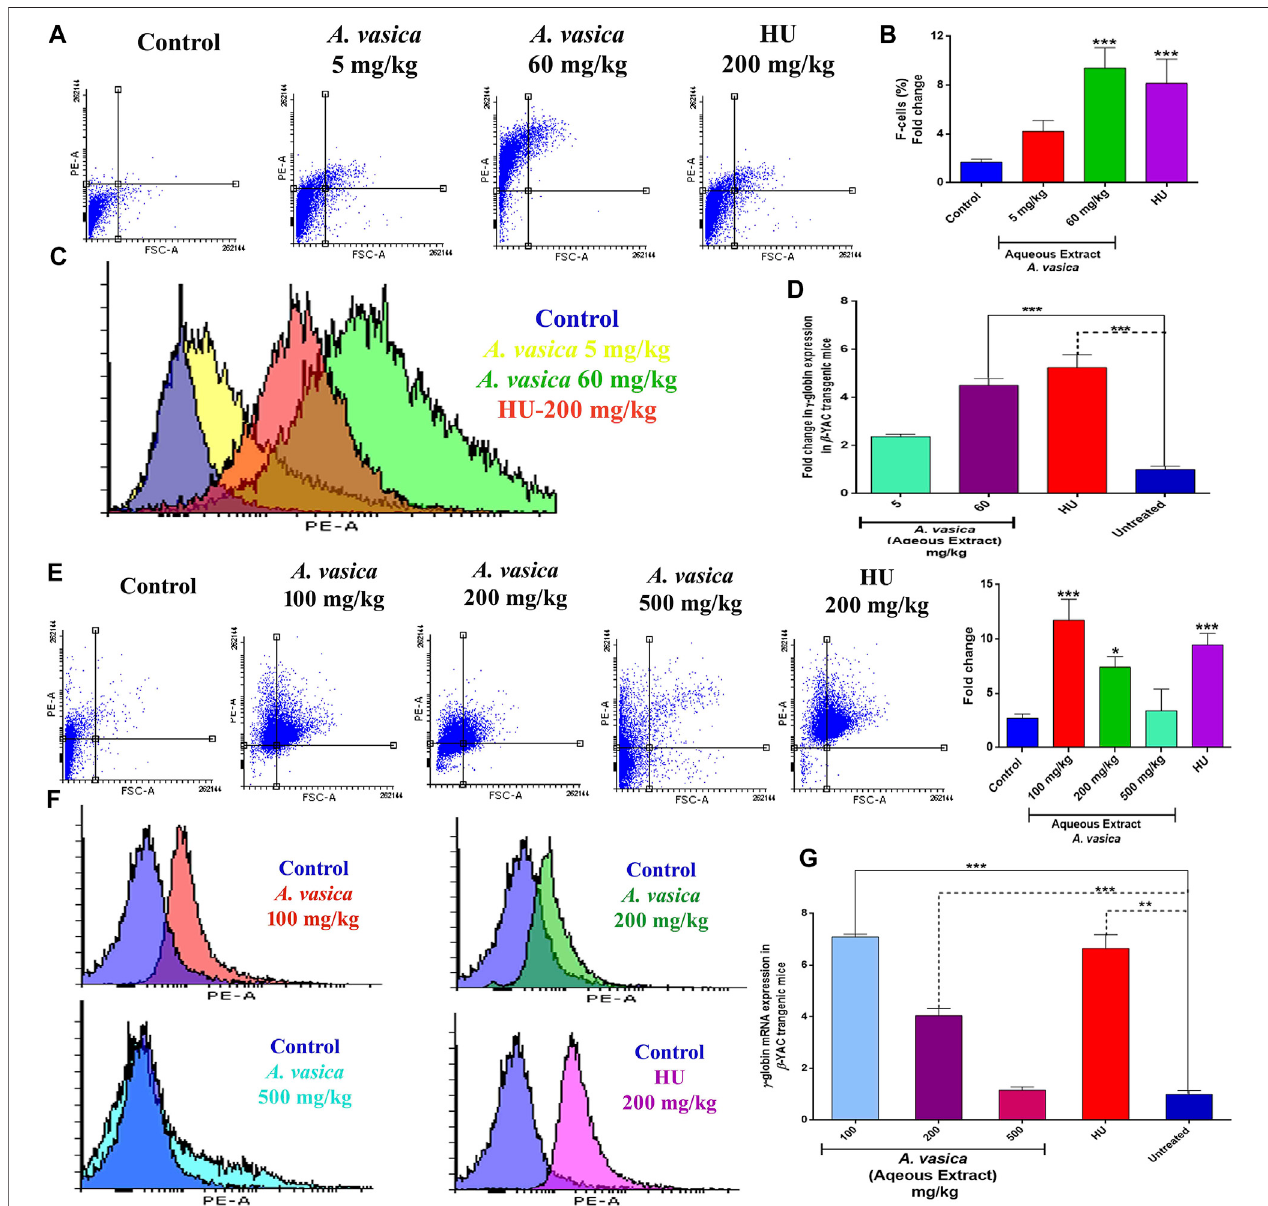
FIGURE 2 | Aqueous extract of A. vasica induces HbF production and γ -globin gene expression in β -YAC transgenic mice. (A) Preliminary administration of the aqueous extract of A. vasica (5 and 60 mg/kg) to mice for 15 days showed HbF-positive cells stained with anti-HbF antibodies observed through the PE channel as represented in dot plots. (B) Quantitative representations of induced HbF levels are shown in the bar graph as percent fold change in F-cells. (C) The histogram demonstrated the level of F-cells (HbF-containing cells) in comparison to the control. (D) The bar graph demonstrated the comparative analysis of γ -globin gene expression in mice treated with the aqueous extract of A. vasica vs. the untreated control. (E) The intraperitoneal injection of 100, 200, and 500 mg/kg of A. vasica were administered to mice for 4 weeks. HbF-positive (F-cells) were analyzed by fl ow cytometry as represented in dot plots and quantitative representation in bar graph representing the percent fold change in F-cells. (F) The overlay histograms of cell population stained positive with anti-HbF antibodies in comparison to control. (G) The relative fold change of γ -globin gene expression in mice after treatment is shown in the bar graph at distinct doses of the aqueous extract of A. vasica . HU (200 mg/kg) and untreated control were taken as controls. The fold change is represented as 2 − ΔΔ Ct . All data are shown as the mean ± SEM (N = 5 per group), and * p < 0.05 was considered statistically signi fi cant.